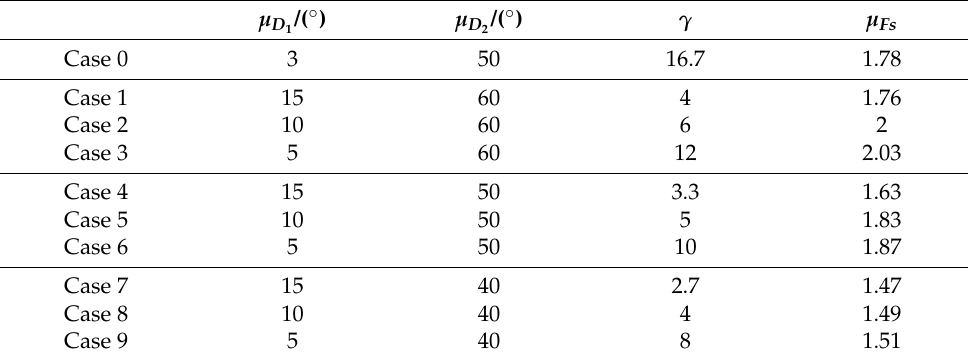
Table 5. Statistical table of the mean dip and mean stability.